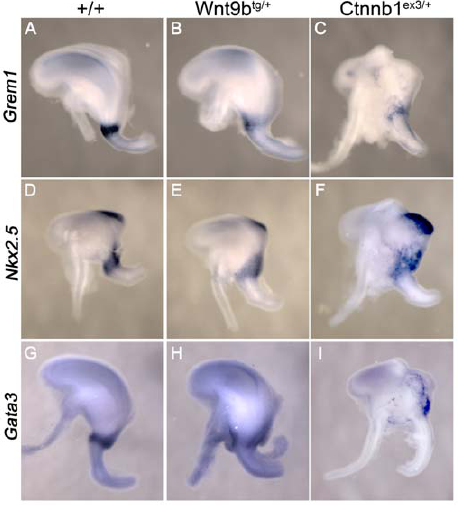
Figure 7. Pyloric gene expression exhibits dose-dependent effects in the Wnt9b and stabilized b -catenin alleles. Whole mount in situ analysis of Grem1 , Nkx2.5 , and Gata3 expression in E12.5 stomachs. All three genes are restricted to the pyloric sphincter in wild- type stomachs ( Six2 -cre tg/ + ). Grem1 and Gata3 show decreased expression in Wnt9b transgenics ( Six2-cre tg/ + , Wnt9b tg/ + ) that is further downregulated in the stabilized b -catenin allele ( Six2-cre tg/ + , Ctnnb1 ex3/ + ). Nkx2.5 expression is expanded into the stomach in Wnt9b transgenics and further upregulated in the stabilized b -catenin allele. Nkx2.5 expression that can be seen at the upper right of the stomach is found in the spleen on the opposite side.